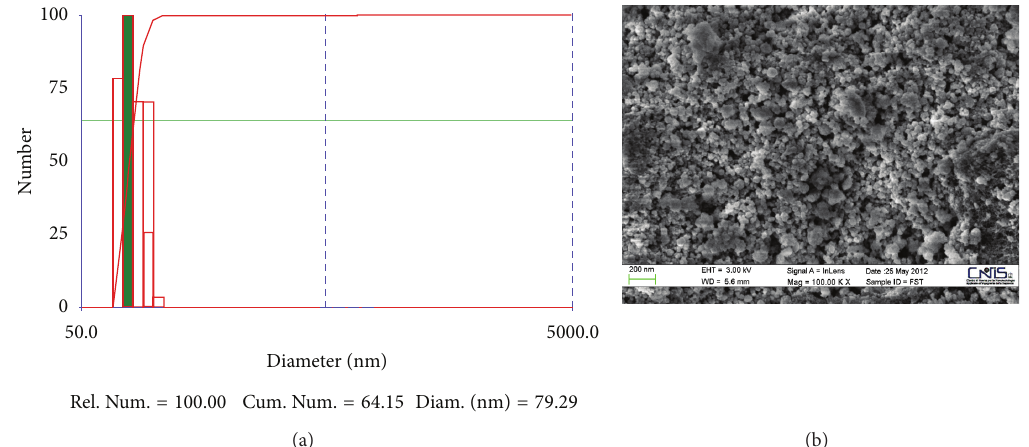
Figure 6: Particle size distribution measured by the nanosizer (a) and TEM photograph (b) of the final ferromagnetic catalyst